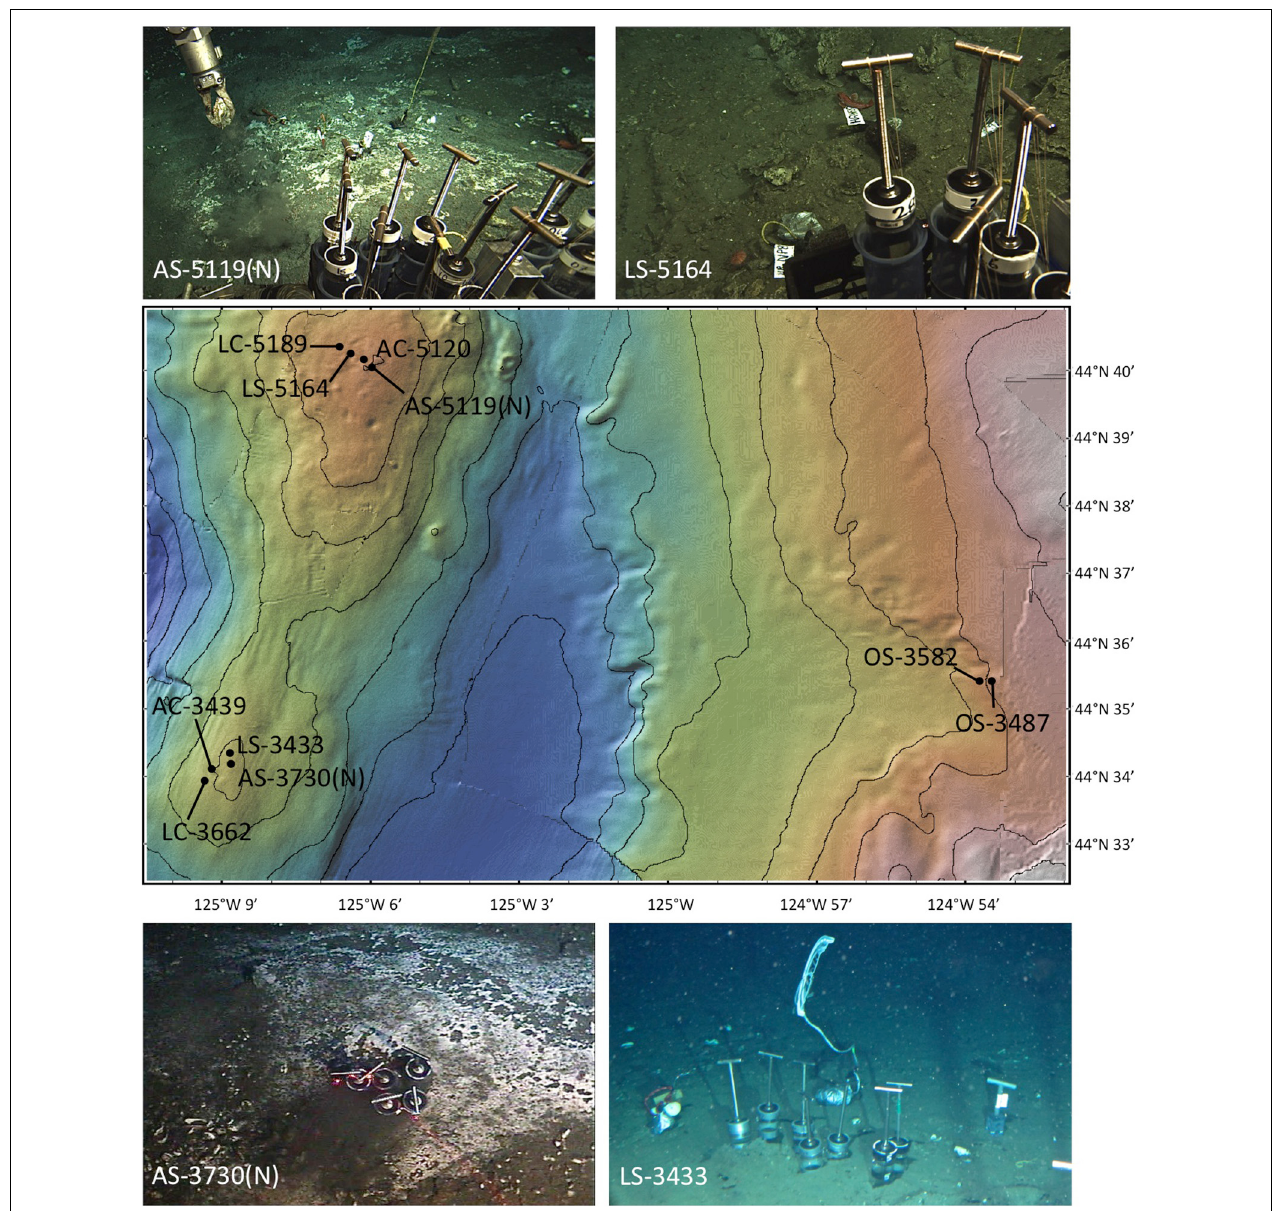
FIGURE 1 | A map of Hydrate Ridge, OR, showing the locations of origin of the samples used in this study, accompanied by images showing the general locations of sample collection. Samples LC-5189, LC-5164, AC-5120, AS-5119, and AS-5119N were collected from Hydrate Ridge north (mound summit ∼ 600m depth); samples AC-3439, LS-3433, LC-3662, AS-3730, and AS-3730N were collected from Hydrate Ridge south (mound